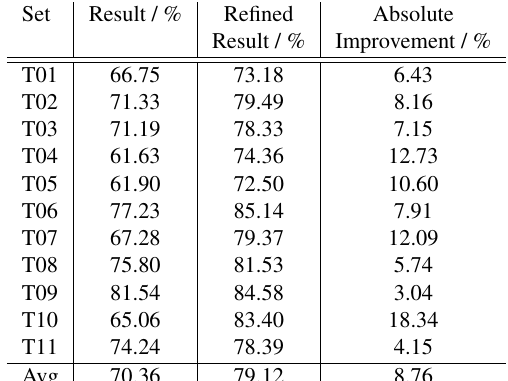
Table 2: Classification results of validation set for training data sets T01 – T11, see Table 1 for